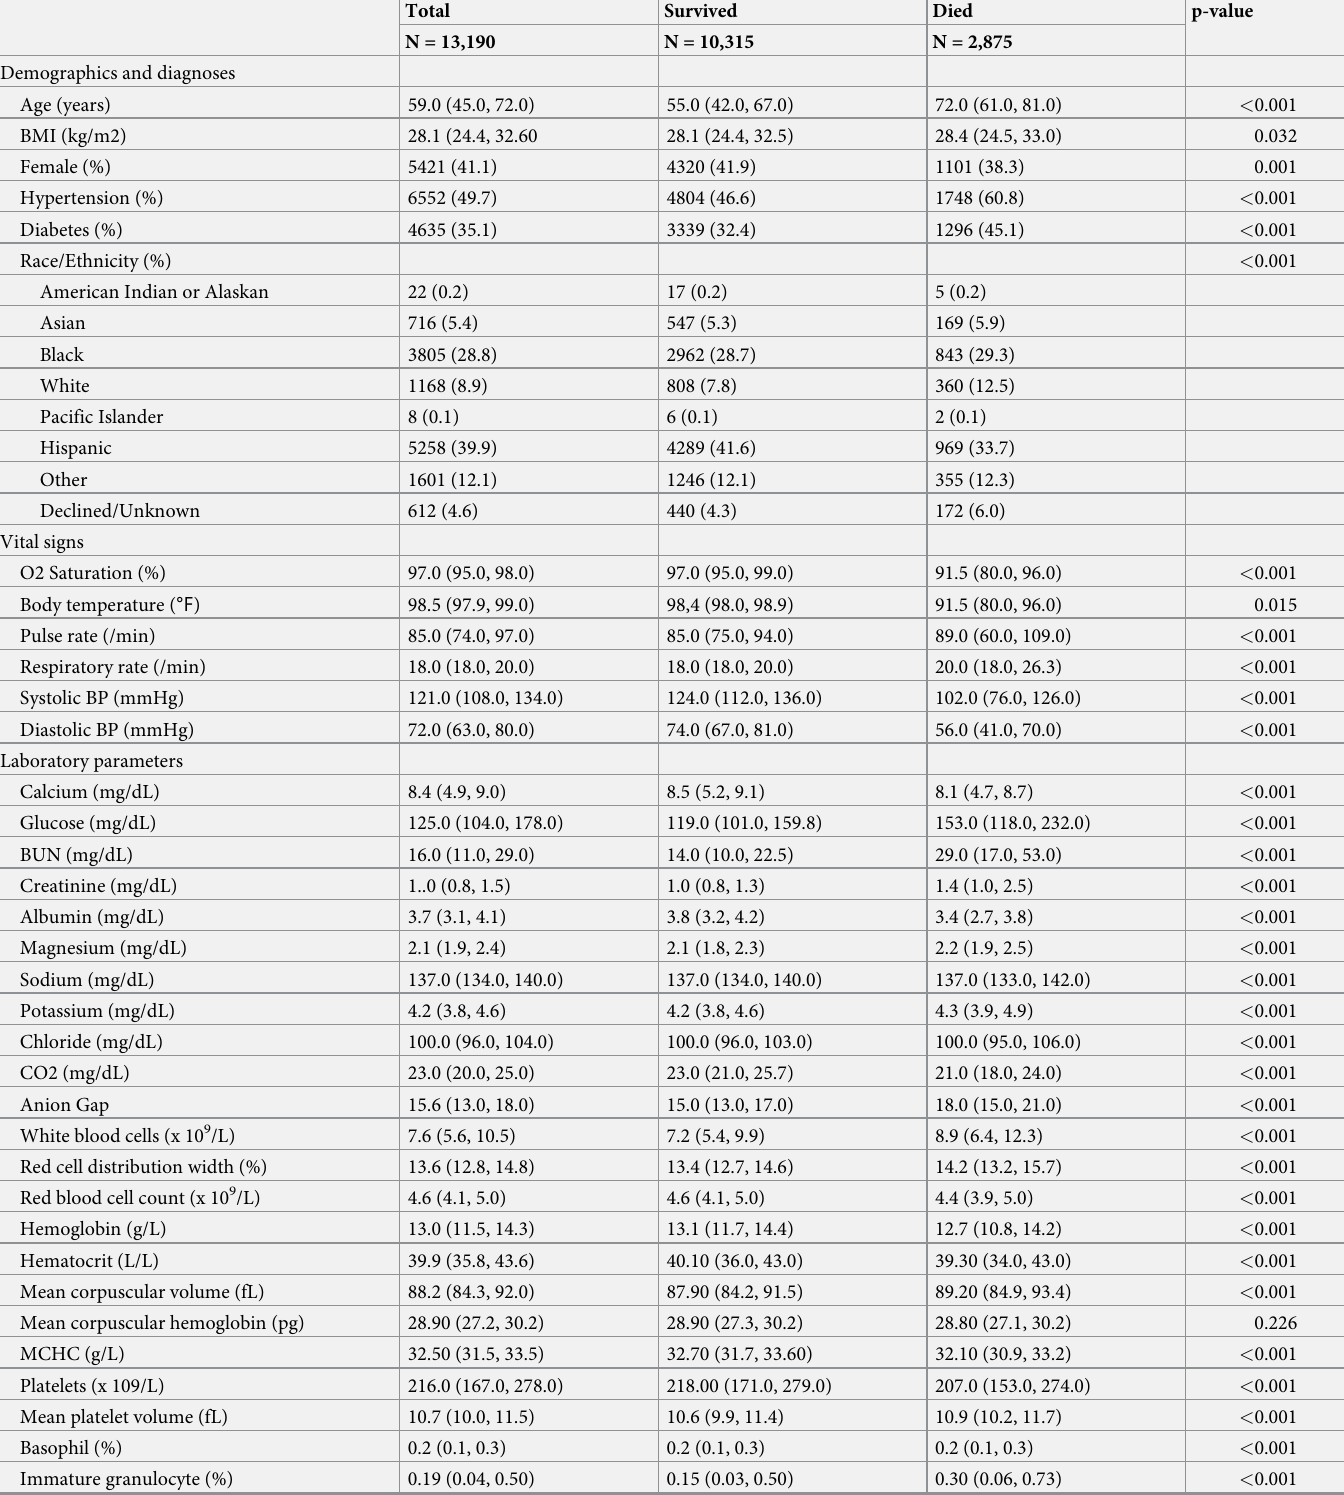
Table 1. Baseline characteristics of the patient population and of those who survived and